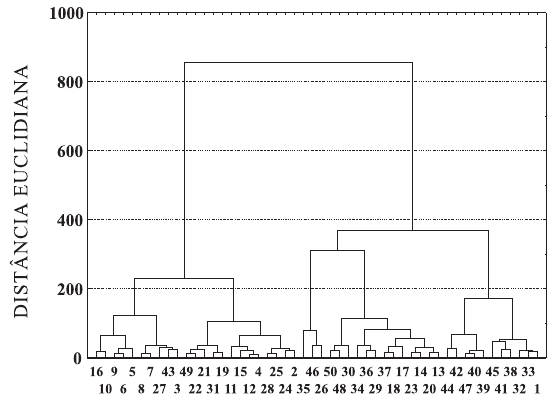
Figura 3. Dendrograma ilustrativo resultante da análise de agrupamento dos atributos químicos do solo.